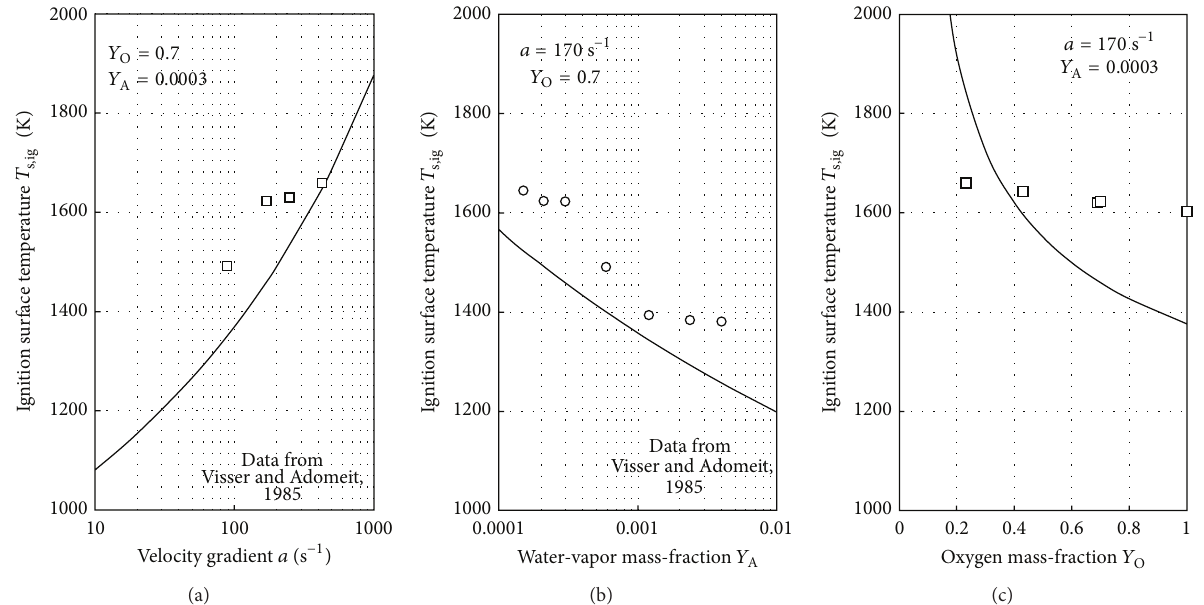
Figure 3: Surface temperature at the establishment of CO flame, as a function of (a) the stagnation velocity gradient; (b) the H 2 O mass- fraction in the freestream; (c) the O 2 mass-fraction. Data points are experimental in [34]; curves are calculated from the theory in [32], with gas-phase kinetic parameters